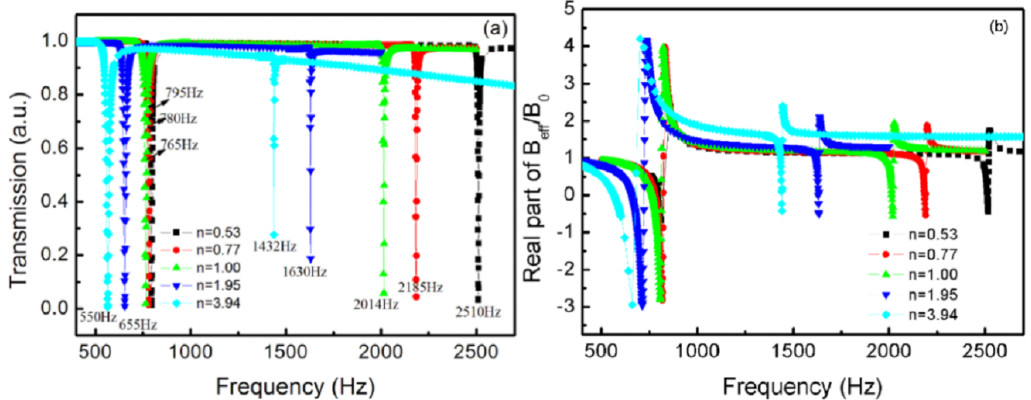
Figure 10. The curves of TLSHSs with various relative volumes: ( a ) transmission and ( b ) effective